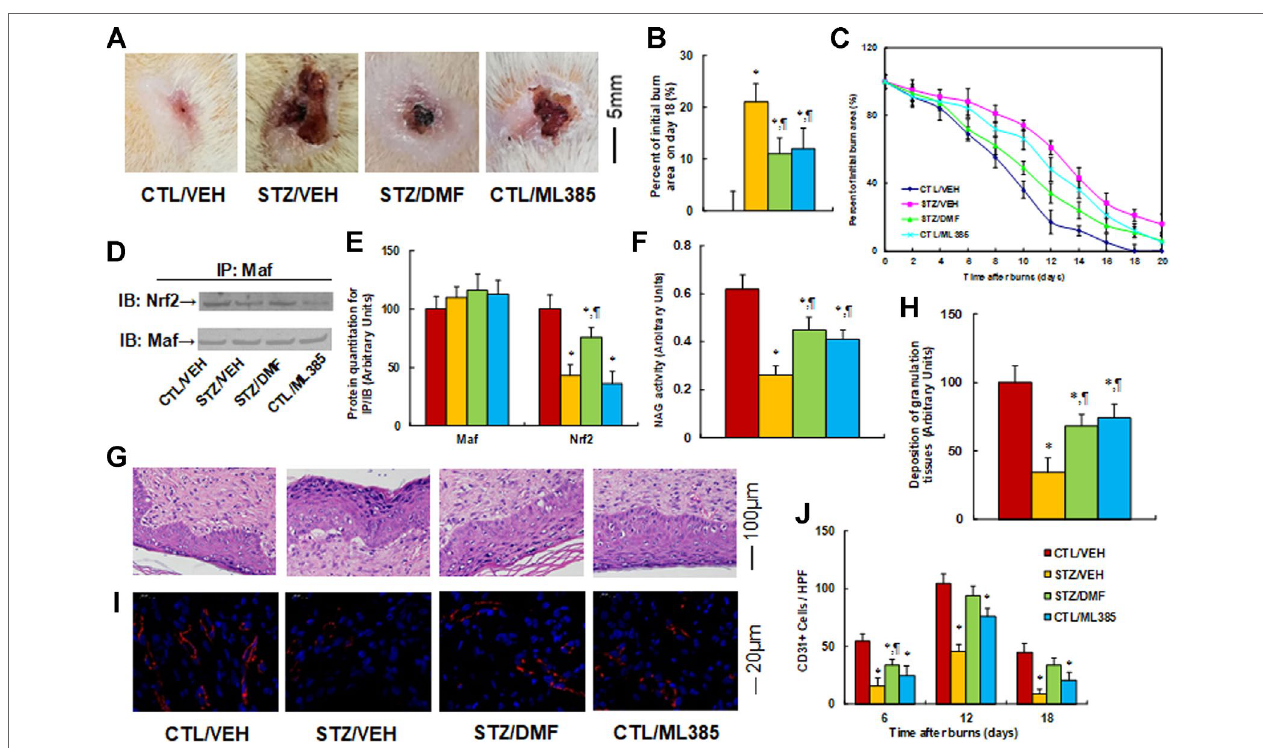
FIGURE 6 | Nrf2 activation accelerates wound healing in diabetic rats, while Nrf2 inhibitor mimics the effect of diabetes. The experimental rats were divided into four groups: control rats (CTL/VEH), STZ diabetic rats (STZ/VEH), STZ rats treated by 15 mg/kg/d of DMF (STZ/DMF), or CTL rats received 15 mg/kg/d of ML385 (CTL/ML385), for further analysis. (A) Photographs of representative wounds on day 12 after burns. (B) Quantitation of burn area on day 18, n = 8. (C) Graphical depiction of wound areas on different days after burns, n = 8. (D) Representative pictures for IP/WB by Maf/Nrf2. (E) Protein quantitation for (D) , n = 5. (F) NAG activity as the marker of macrophage accumulation, n = 5. (G) Hematoxylin-eosin stains of wound tissues on day 12 after burns with occurrence of granulation tissue in the wounds. (H) Deposition of granulation tissues, n = 8. (I) The representative pictures for evaluation of vascularity (assessed by